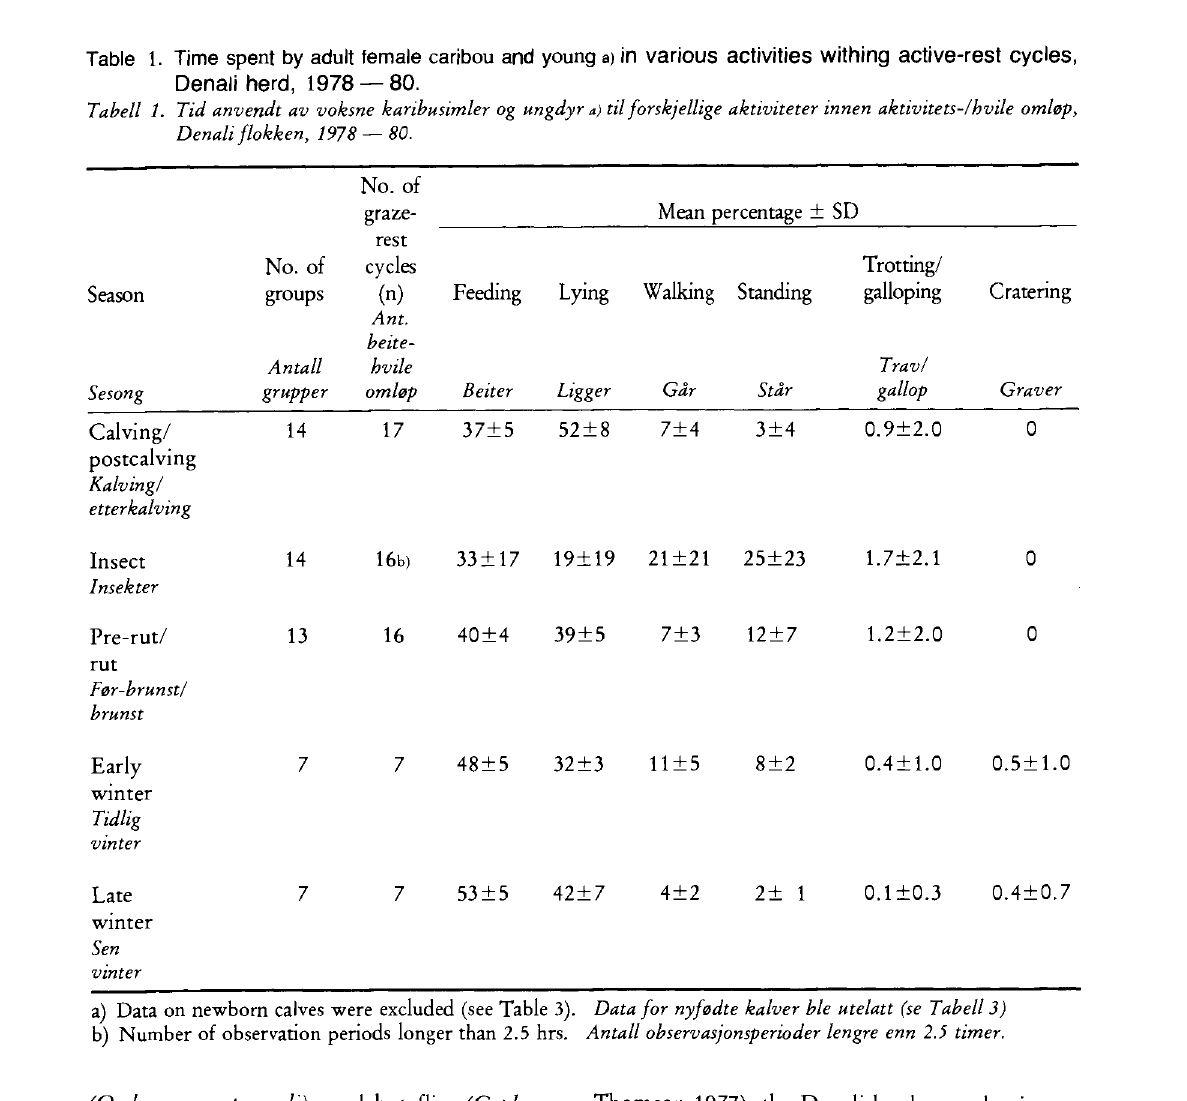
Table 1. Time spent by adult female caribou and young a) in various activities withing active-rest cycles, Denali herd, 1978 —